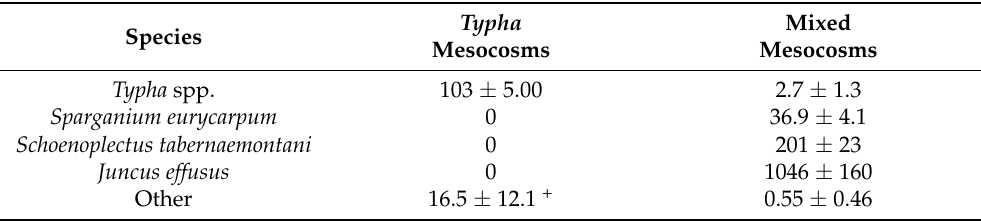
Table 5. Mean macrophyte stem counts ( ± standard error) in November 2008 by vegetation treatment in